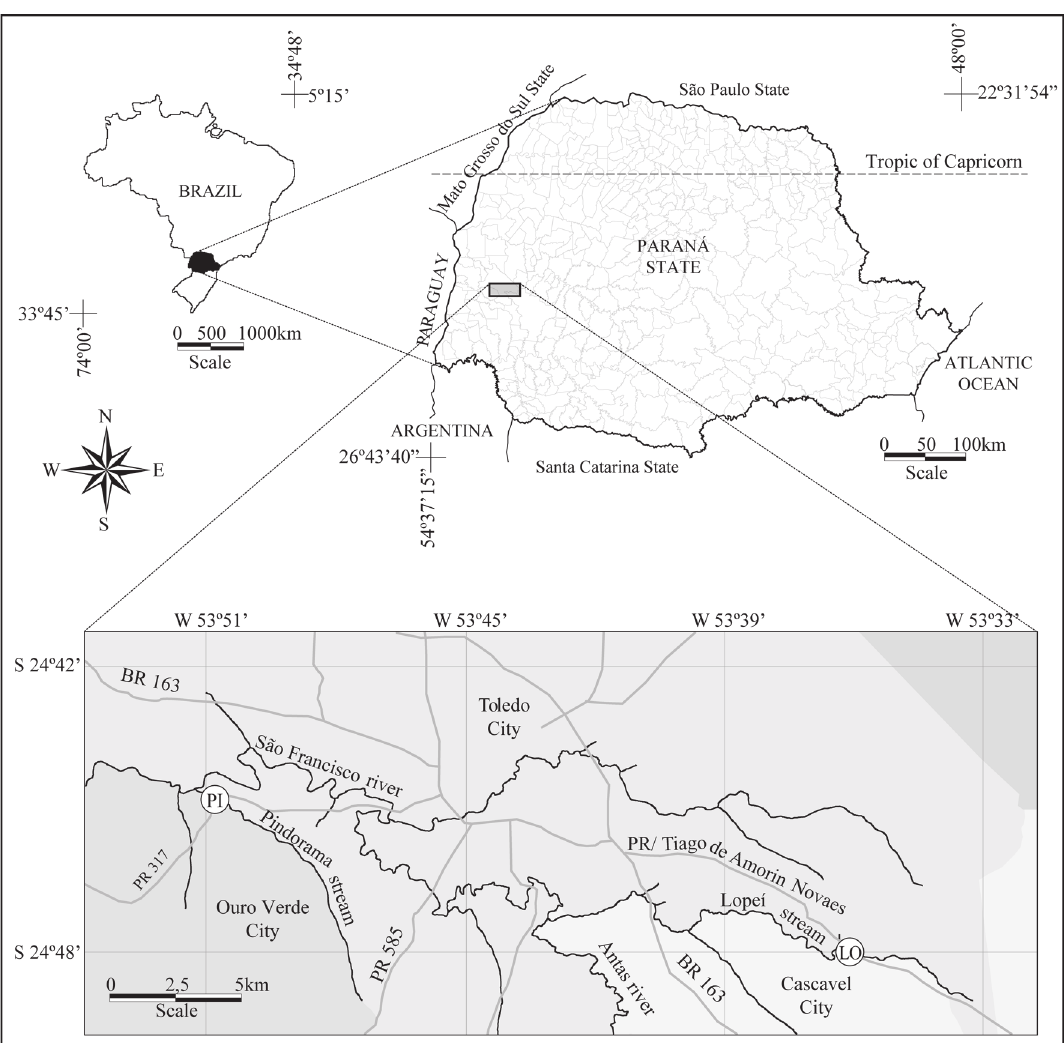
Fig. 1. Sampling sites in the Pindorama (PI) and Lopei (LO) streams, Paraná State,